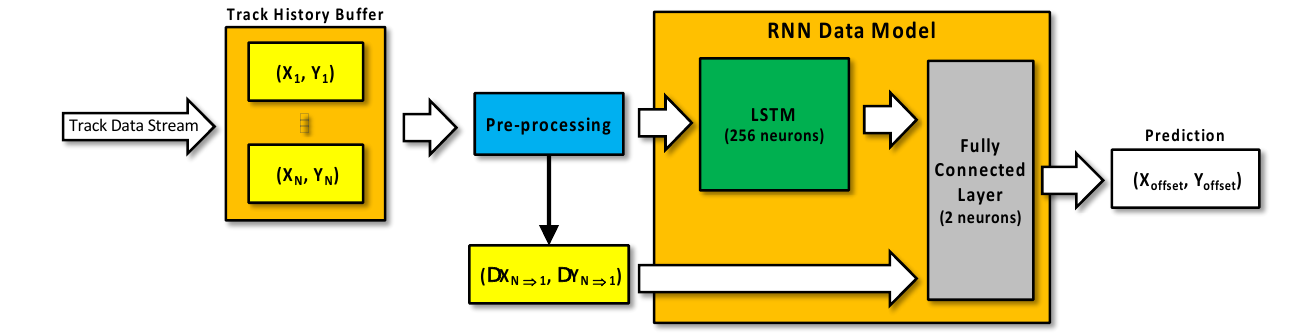
Figure 11. RNN data model of 3D Video system .